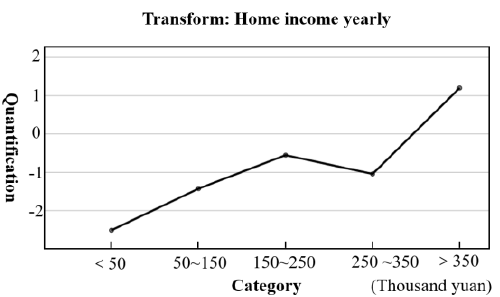
Figure 8. The quantization of the variable of yearly household income.